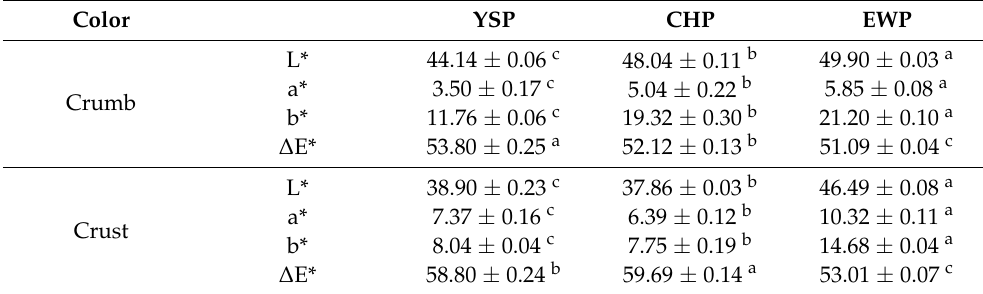
Table 3. Characteristics of aquasoya muffins with yellow soybean powder (YSP), chickpea powder (CHP), and egg white powder (EWP): colors of the crumb and